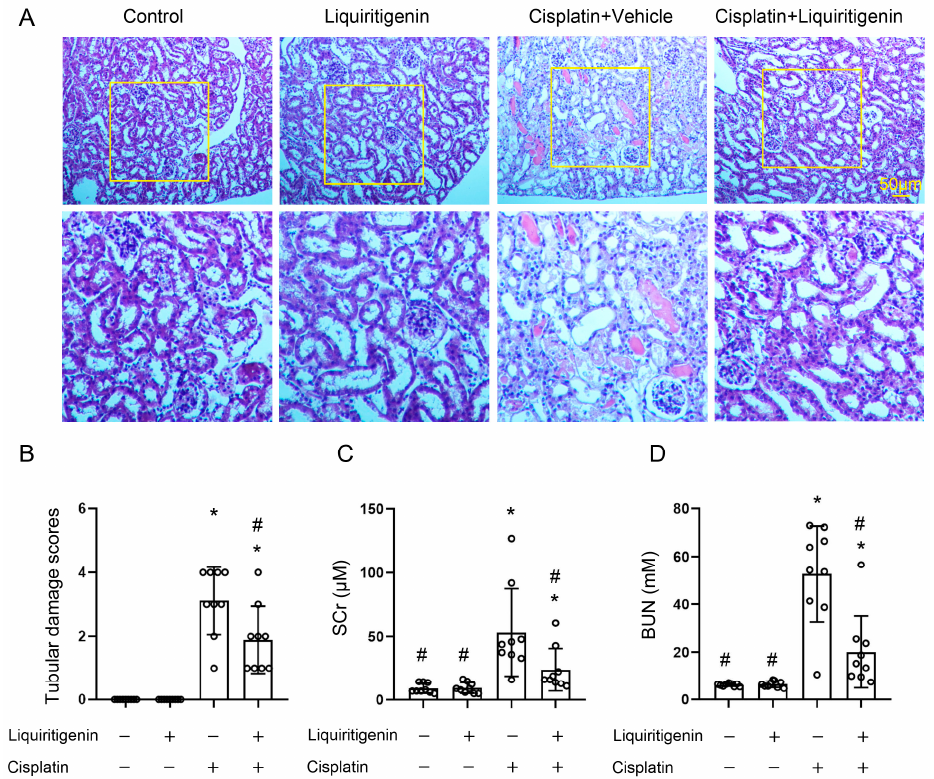
Figure 1. The effect of liquiritigenin on AKI induced by CP in mice. ( A ) Representative micrographs of HE staining in the kidney from different groups of mice. ( B ) Quantitative pathological assessment of tubular damage from different groups of mice. Renal morphology was scored according to the proportion of damaged renal tubules, such as brush border, tubule dilatation, and cast formation in the total renal tubules. The scoring criteria were as follows: 0, normal; 1, <10%; 2, 10~25%; 3, 26~50%; 4, 51~75% and 5, >75%. * p < 0.05 vs. control group of mice, # p < 0.05 vs. mice with CP treatment ( n = 9 mice/group). ( C ) Serum creatinine levels of mice in different groups. * p < 0.05 vs. control group of mice, # p < 0.05 vs. mice with CP treatment ( n = 9 mice/group). ( D ) Blood urea nitrogen levels of mice in different groups. * p < 0.05 vs. control group of mice, # p < 0.05 vs. mice with CP treatment ( n = 9 mice/group).